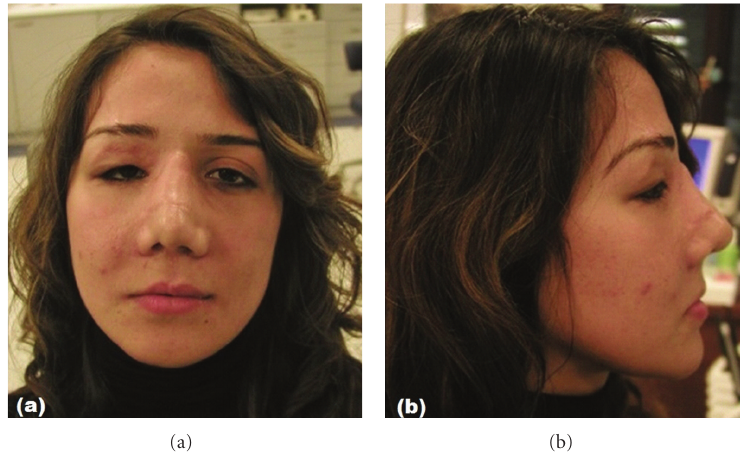
Figure 1: Facial view of patient before treatment with soft tissue defects on the eye area.